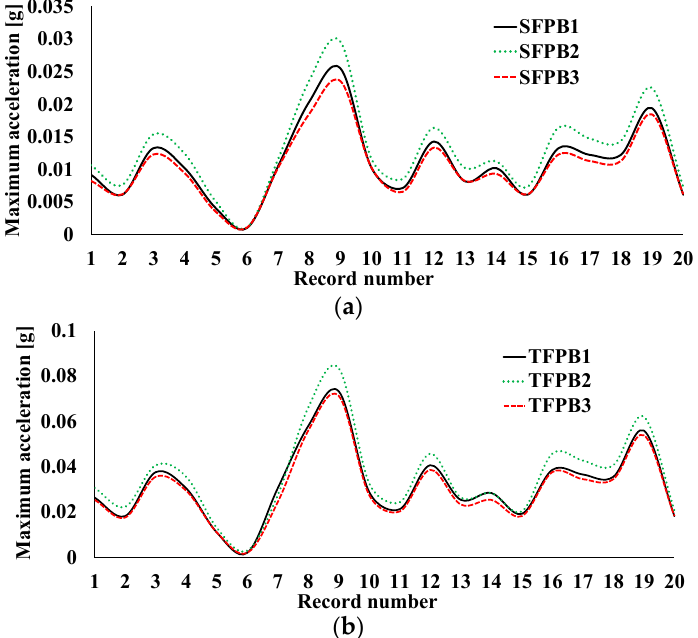
Figure 10. Base accelerations of the storage tank for: ( a ) SFPB and ( b ) TFPB isolation schemes.